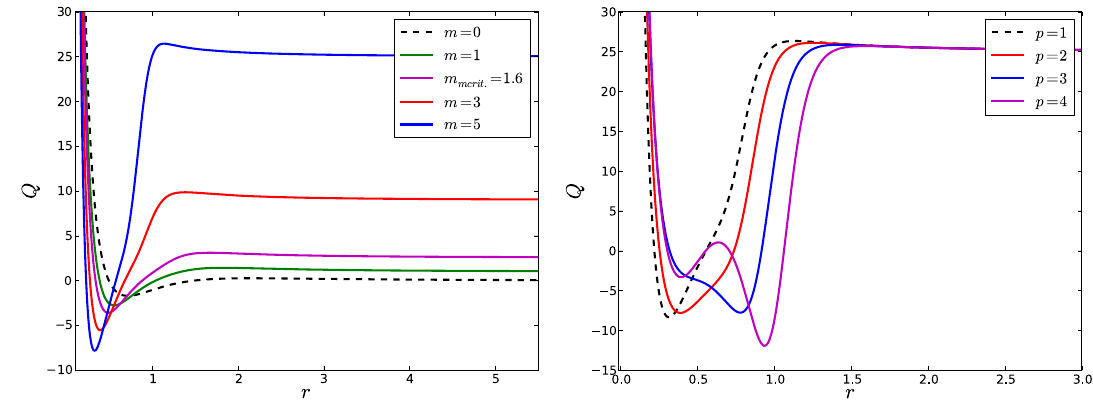
Figure 3 . E(cid:11)ective potential Q for the L 240 Skyrme model. Left: with the usual Skyrme potential and di(cid:11)erent values of the mass m . Right: with the Lin-Piette potentials